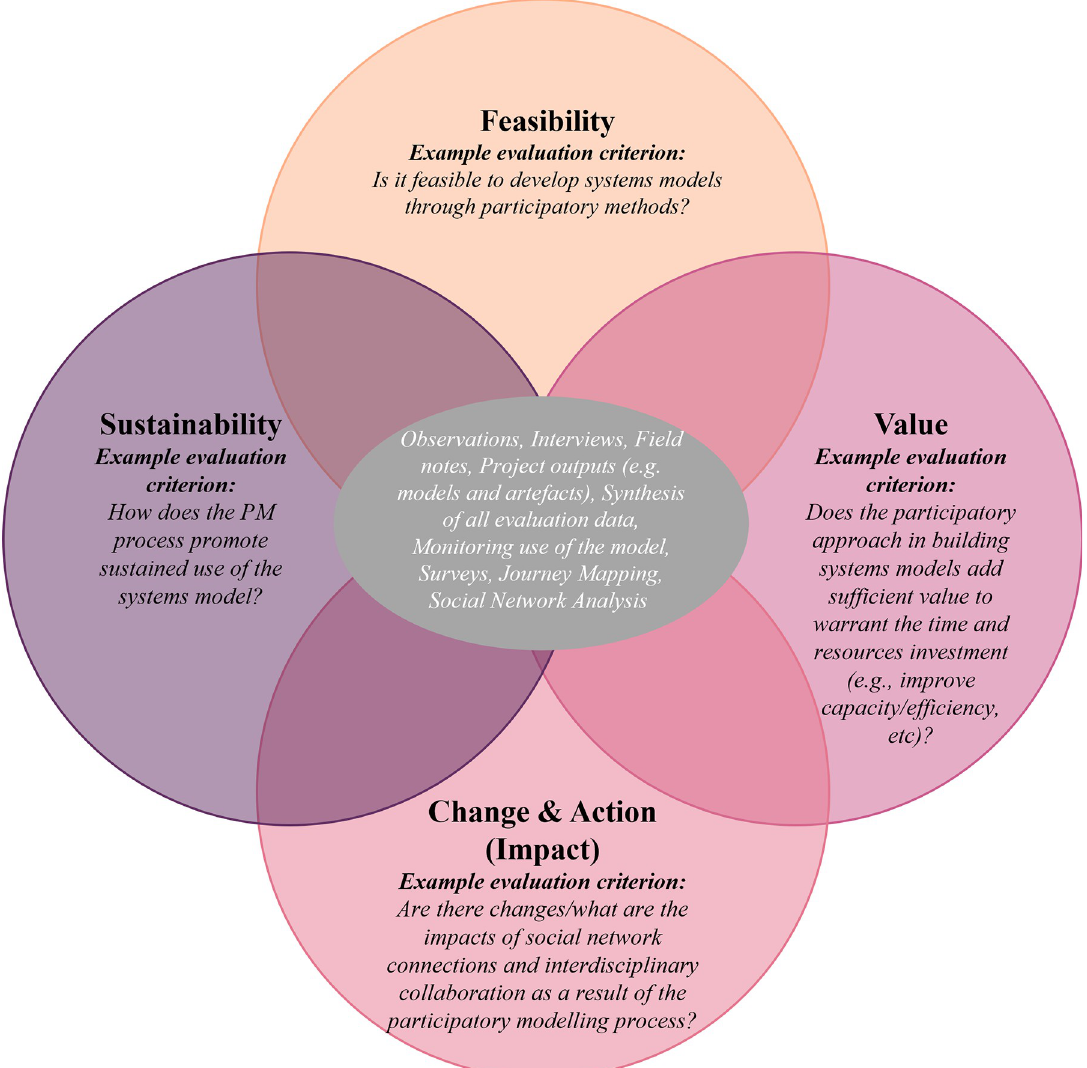
Fig 5. Potential methods of data collection to adopt the comprehensive multi-scale framework into evaluation practice.